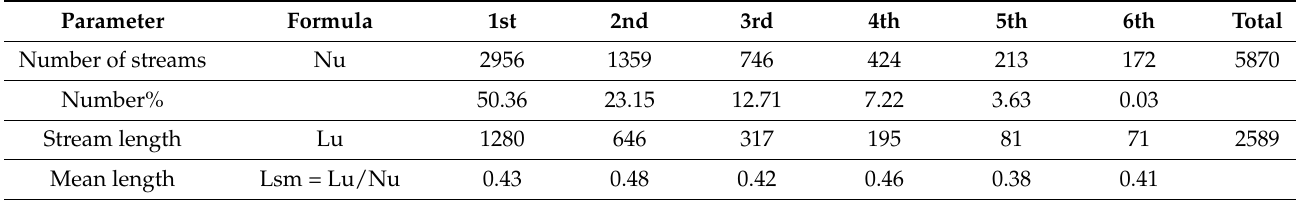
Table 4. Morphometric aspects of the study